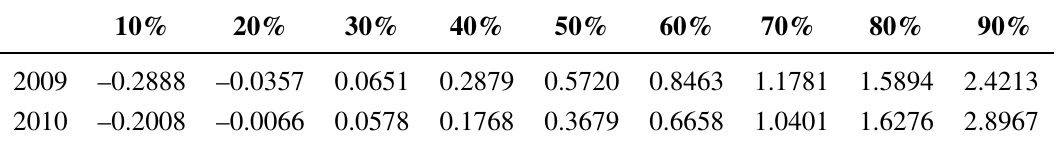
= | H SV |−| H MT | , described in Figure 3, for y = y y y